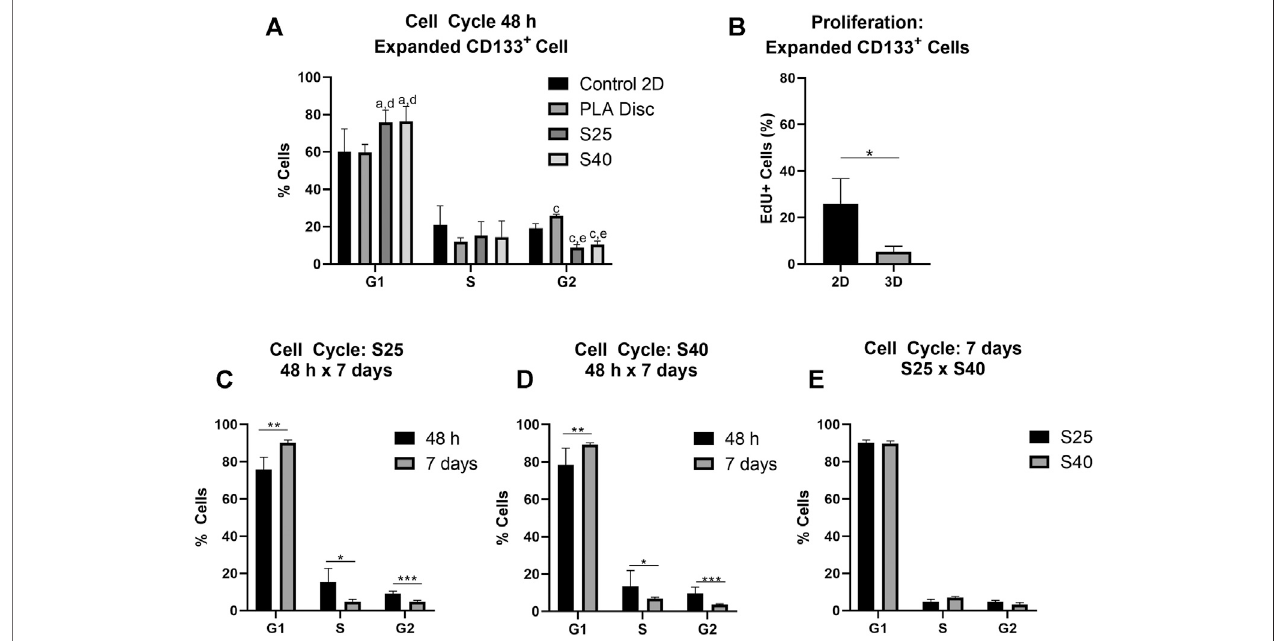
FIGURE4| ExpandedCD133+cellcycleandproliferationafterthecultureonthePLAscaffolds. (A) PercentageofexpandedCD133 + cellsineachofthephasesof the cell cycle after 48 h of culture on the scaffolds in comparison to the culture on the PLA disc and the control (Control 2D n (cid:1) 6; PLA disc n (cid:1) 3; S25 n (cid:1) 8; S40 n (cid:1) 8). Analysisbyone-wayANOVA: a p ≤ 0.05incomparisontothecontrol2D; c p ≤ 0.001incomparisontothecontrol2D; d p ≤ 0.05incomparisontothePLAdisc; e p ≤ 0.01in comparison to the PLA disc (B) Cell proliferation analysis by EdU incorporation after 48 h of culture on the 3D scaffold in comparison to the control 2D (Control 2D n (cid:1) 2; 3D n (cid:1) 3) (C) Percentage of cells in each of the phases of the cells cycle after 48 h and 7 days of culture on the S25 (S25 7 days n (cid:1) 5) (D) and on the S40 (S40 7 days n (cid:1) 4) (E) Comparisonofthepercentageofcellsineachofthephasesofthecellcycleafter7 daysofcultureontheS25andS40.Forthe3Dscaffoldsnrepresents the number of scaffolds that were analyzed. Graphs are represented by the mean ± SD. Student ’ s unpaired t-test analysis: * p ≤ 0.05; ** p ≤ 0.01; *** p ≤